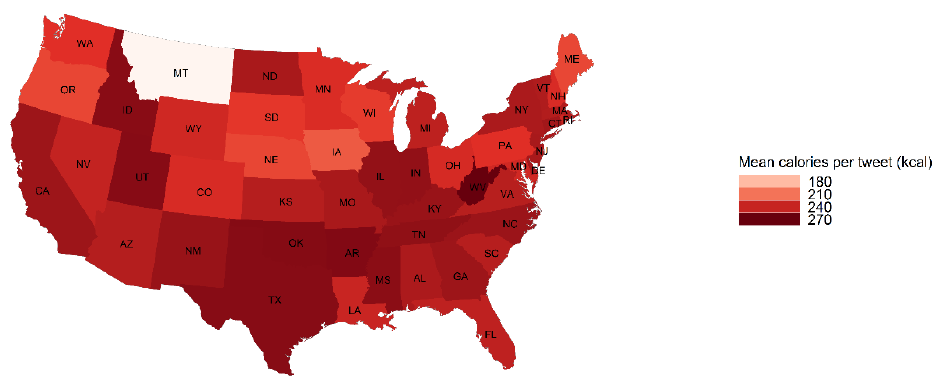
Figure 1. State level percent of food tweets with a fast food mention in the contiguous United States, Twitter 2015–2018.